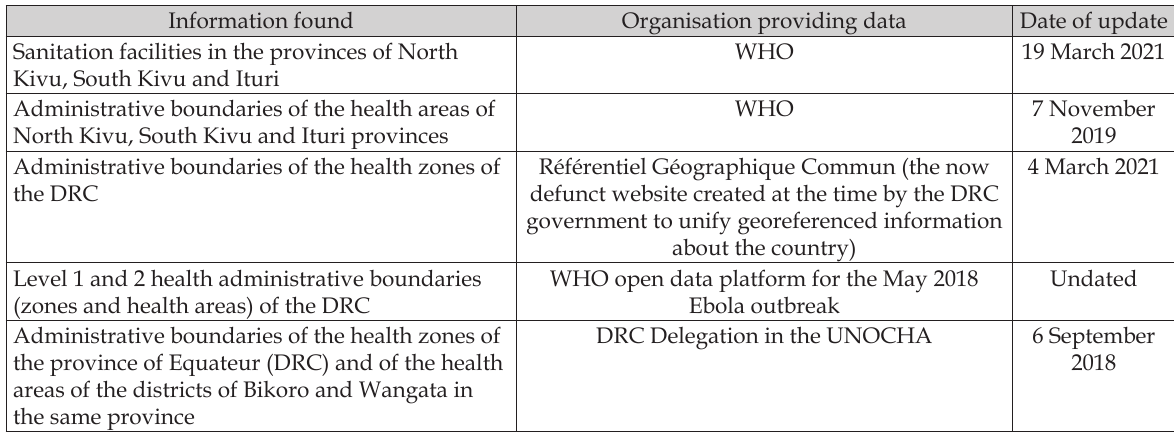
Table 2. Results of the double search performed with the terms ‘Democratic Republic of the Congo’ and ‘Ebola’ in the HDX